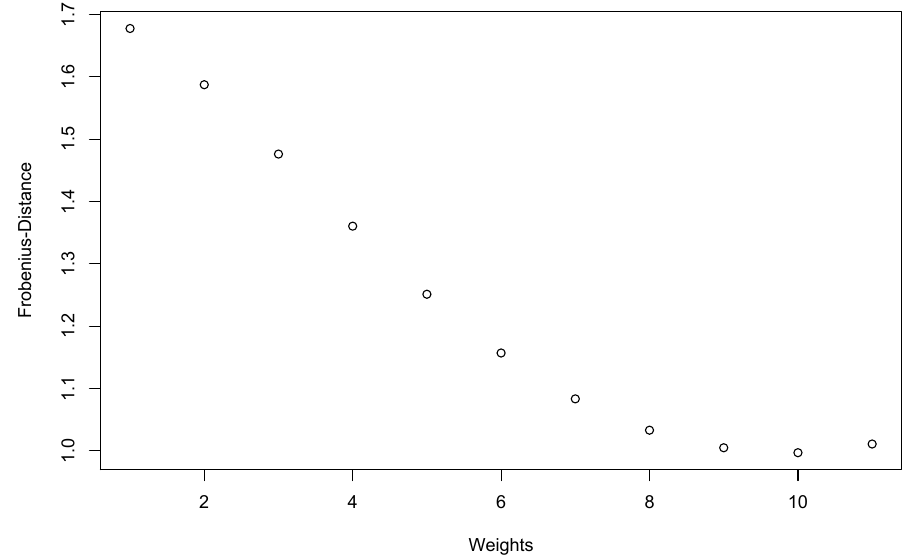
Figure 3. Impact of weights on the Frobenius norm, in the case of the example G 51 .